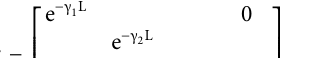
Frontiers in Physics |